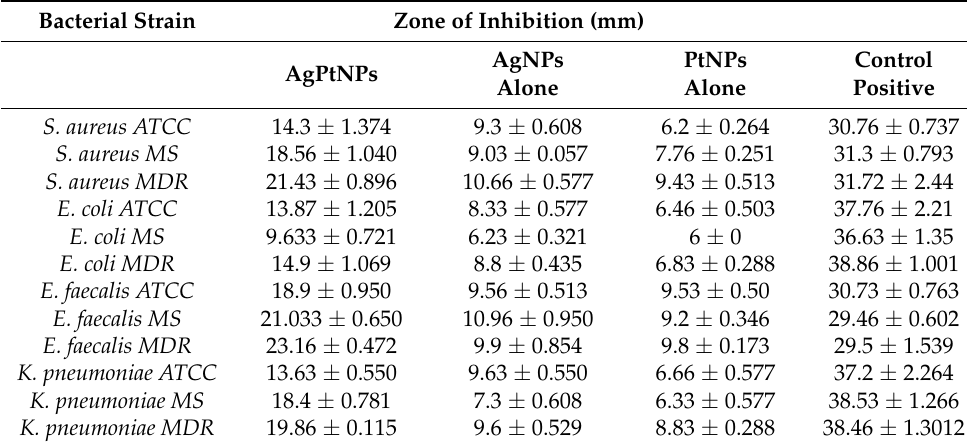
Table 3. Inhibition zone (mm) of AgPtNPs against ATCC, MS and MDR bacterial strains. (±SD 3 replicates tested). Positive Control is Vancomycin for Gram-positive and Ampicillin for Gram- negative.